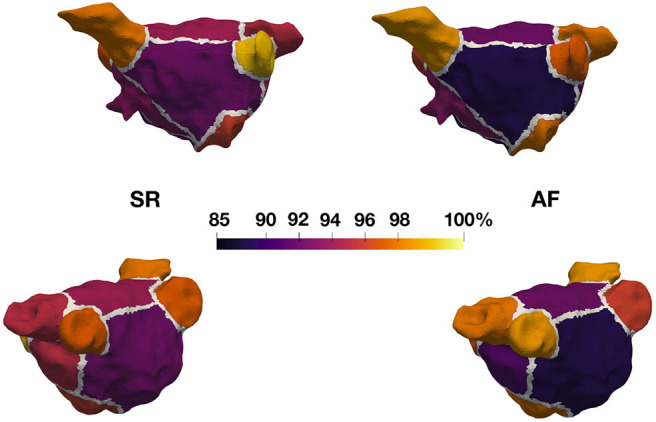
Regional agreement of unipolar and bipolar substrate classification. Eleven anatomical regions were annotated in all 28 patient geometries and analyzed in SR and AF. Each region visualized on this example geometry is colored according to the mean percentage of concordantly categorized mapping sites (unipolar vs. bipolar voltage mapping) with regard to LVA.